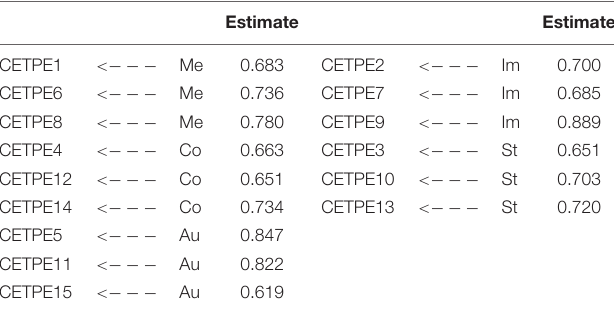
TABLE 9 | Standardized regression weights: (group number 1 – default